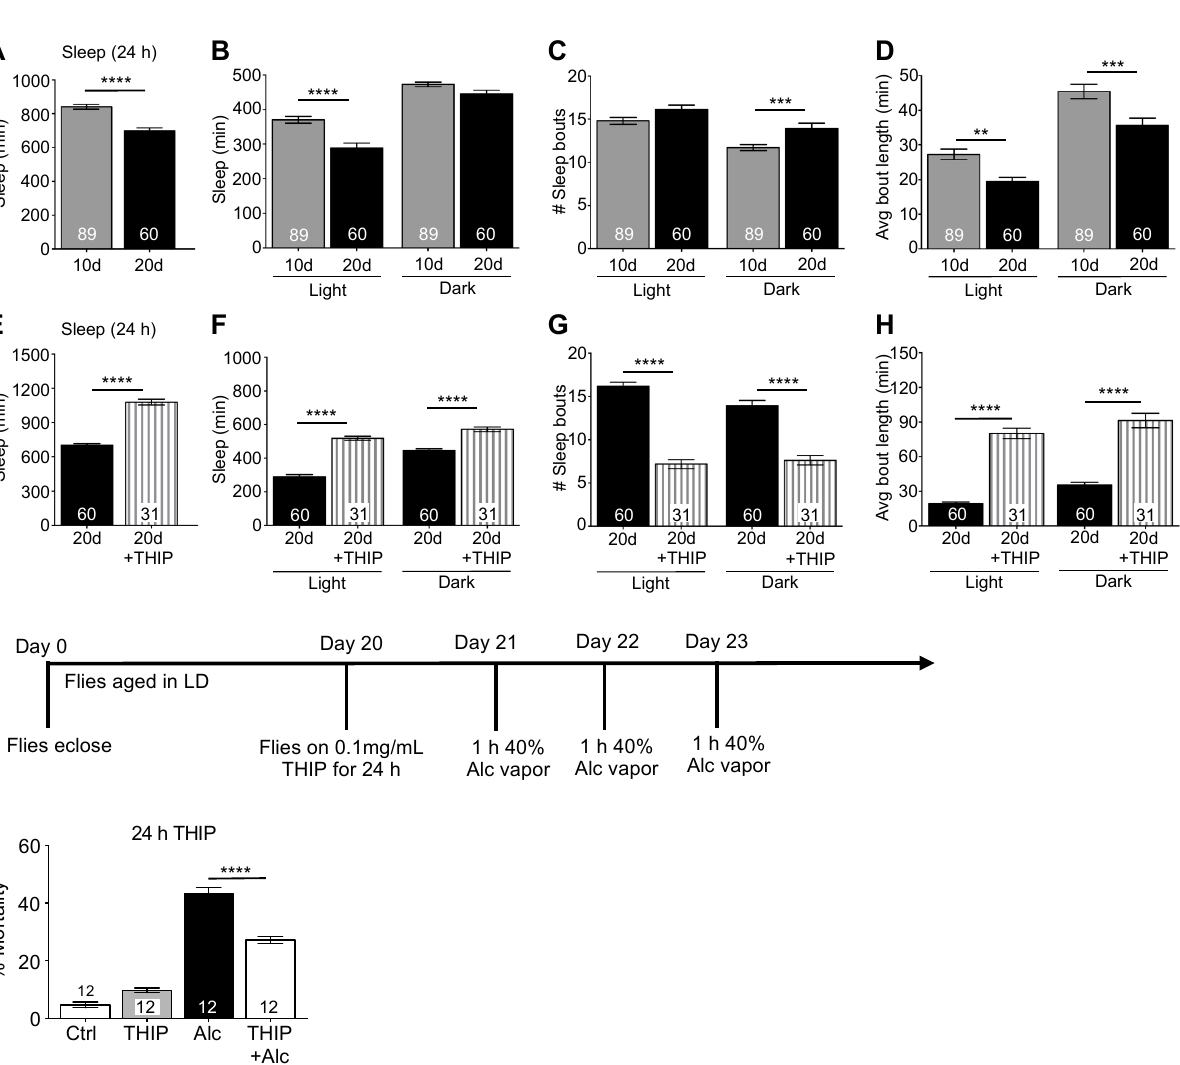
Figure 9. Pharmacologically increasing sleep in aging ameliorates alcohol-induced mortality. Com- pared to young 10 d flies, male 20 d flies grown in LD cycles exhibited significantly decreased average sleep time per day ( A ), decreased sleep during both the light and dark cycles ( B ), an increased number of sleep bouts ( C ), and decreased bout duration ( D ). ( E – H ) Flies 20 days of age fed 0.1 mg/mL THIP exhibited significantly greater total sleep ( E ) compared to 20 d flies on control media, ( F ) increased daytime and nighttime sleep, ( G ) a decreased number of sleep bouts, and ( H ) increased bout length. ( I ) Flies were grown in 12 h light: 12 h dark cycles and transferred to media containing 0.1 mg/mL THIP on day 19 for 24 h. On days 20, 21, and 22, flies were subjected to a 3-exposure repeated binge- like alcohol paradigm with 1 h alcohol exposure (40% alcohol vapor) occurring at ZT 9, and mortality was assessed. ( J ) Increased rest in 20 d THIP-fed flies significantly ameliorated alcohol-induced mortality compared to 20 d flies fed control media (ANOVA F 3,44 = 243.8, p < 0.0001). * indicates significant differences between groups as calculated by Bonferroni post hoc analysis; ** p < 0.01, *** p < 0.001, **** p < 0.0001.